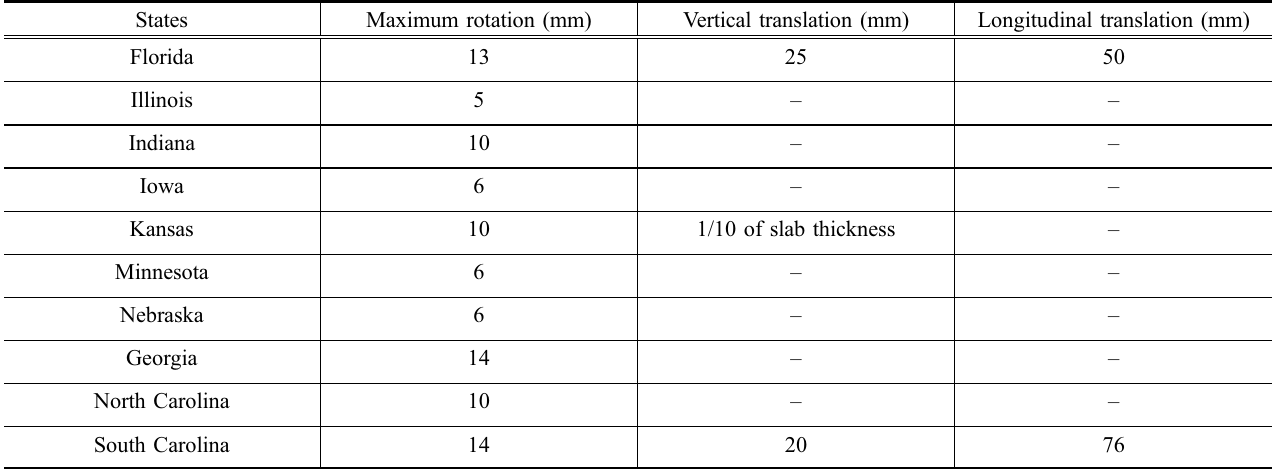
Table 2 Specification of dowel bar misalignment